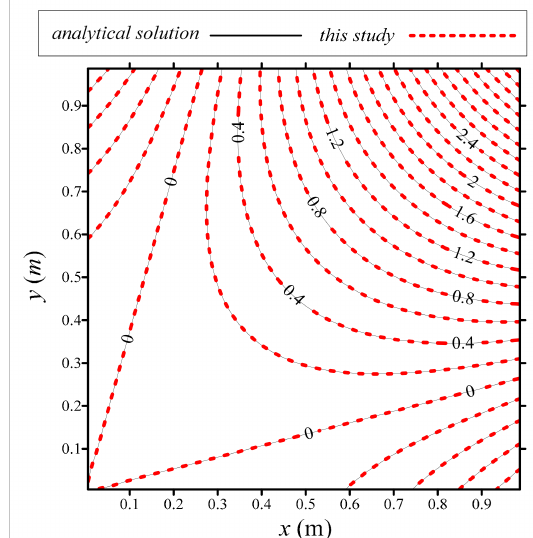
Figure 17. Comparison between the numerical solution and the exact